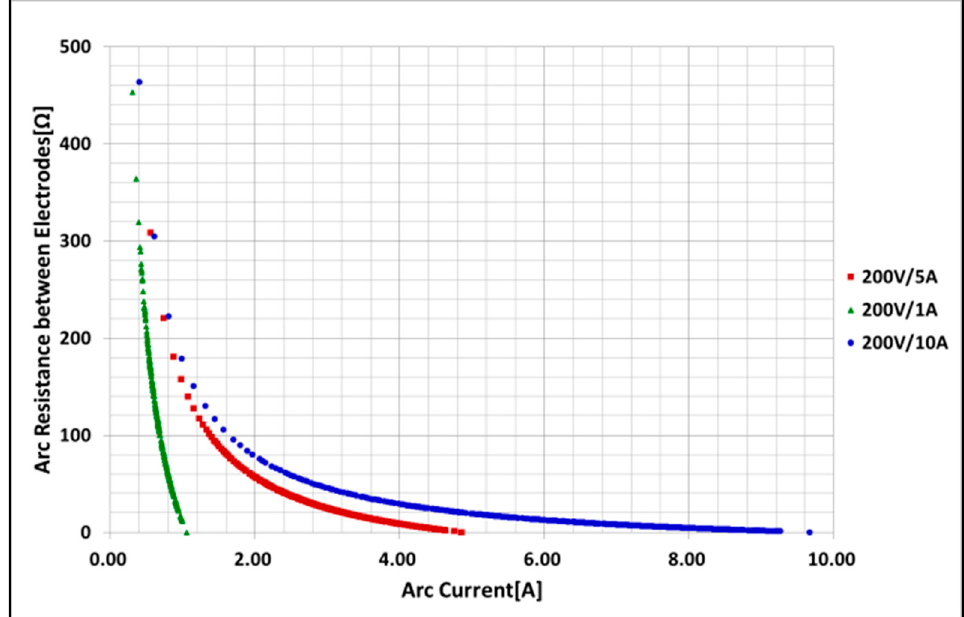
Figure 15. Arc resistance and arc current experimental results (load current change).